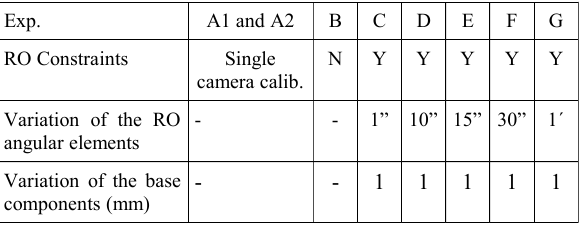
Table 2. Characteristics of the seven experiments with real data.